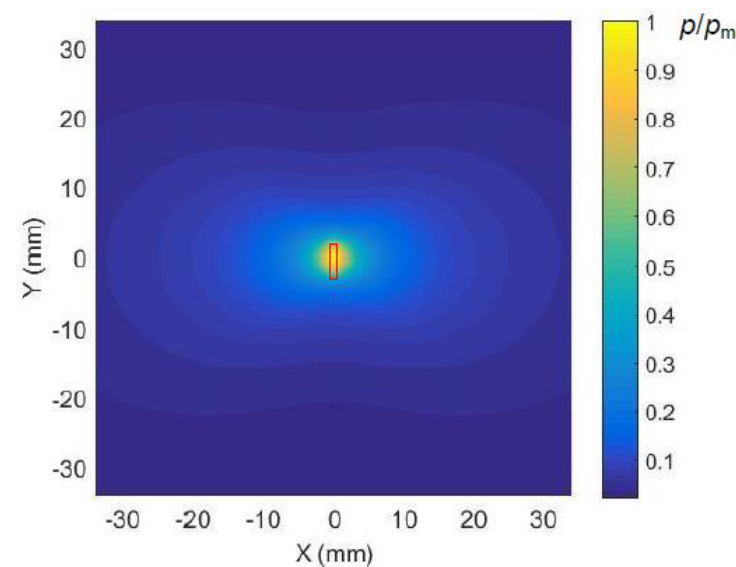
Figure 8. The calculated spatial distribution of maximal values of the ultrasonic pressure field in air radiated by a single rectangular array element (shown by a solid red line) field in the plane of the film at the distance R = 1 mm from the element. The presented amplitude values shown in the color bar were normalized with respect to the maximum value in the field.